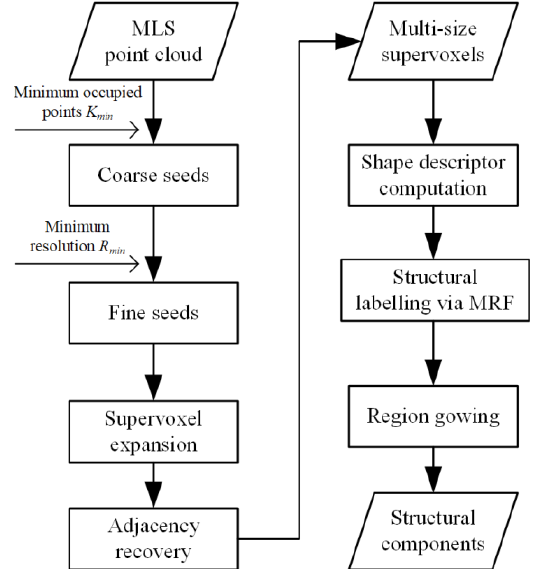
Figure 1. Overview of the proposed method.